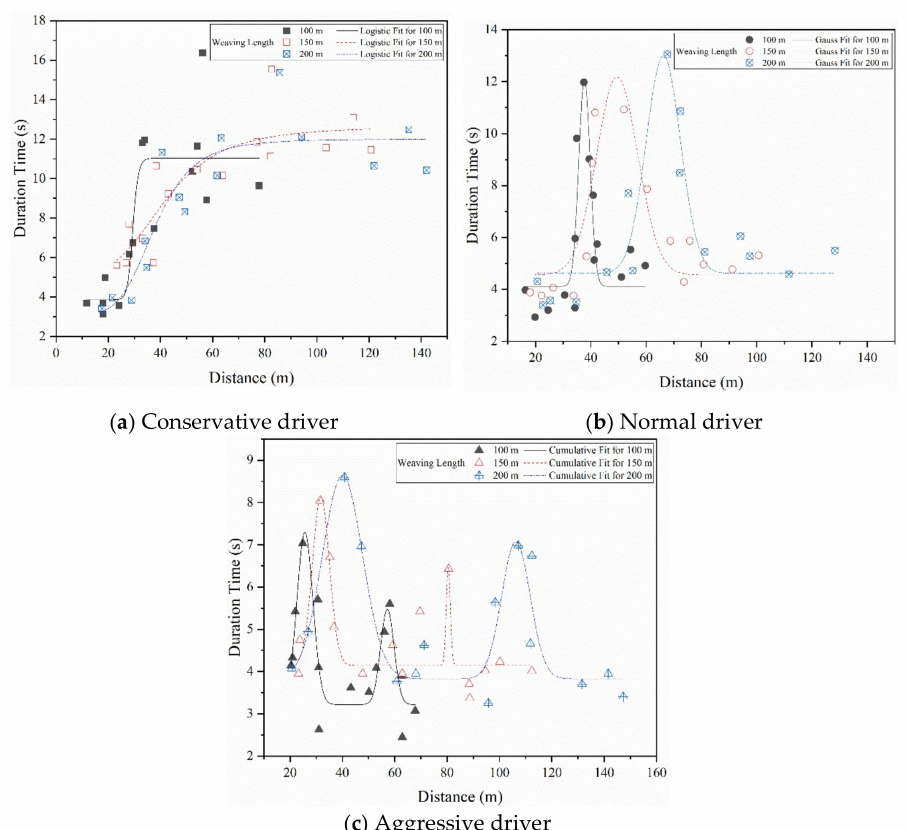
Figure 11. Lane-change position and duration at different weaving